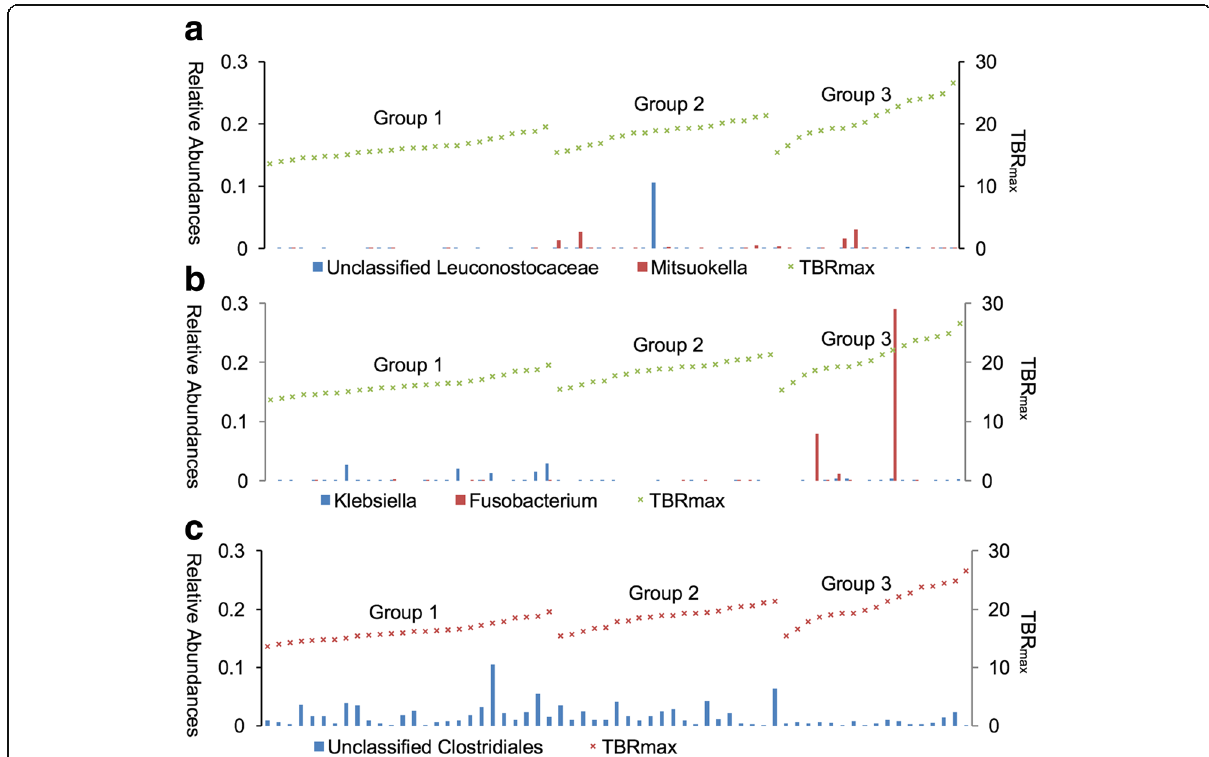
Fig. 4 Relative abundances of the genera showing significant difference between groups; ( a )Unclassified Leuconostocaceaeand Mitsuokella , ( b ) Klebsiella and Fusobacterium , ( c ) unclassified clostridiales (Data are demonstrated according to TBR